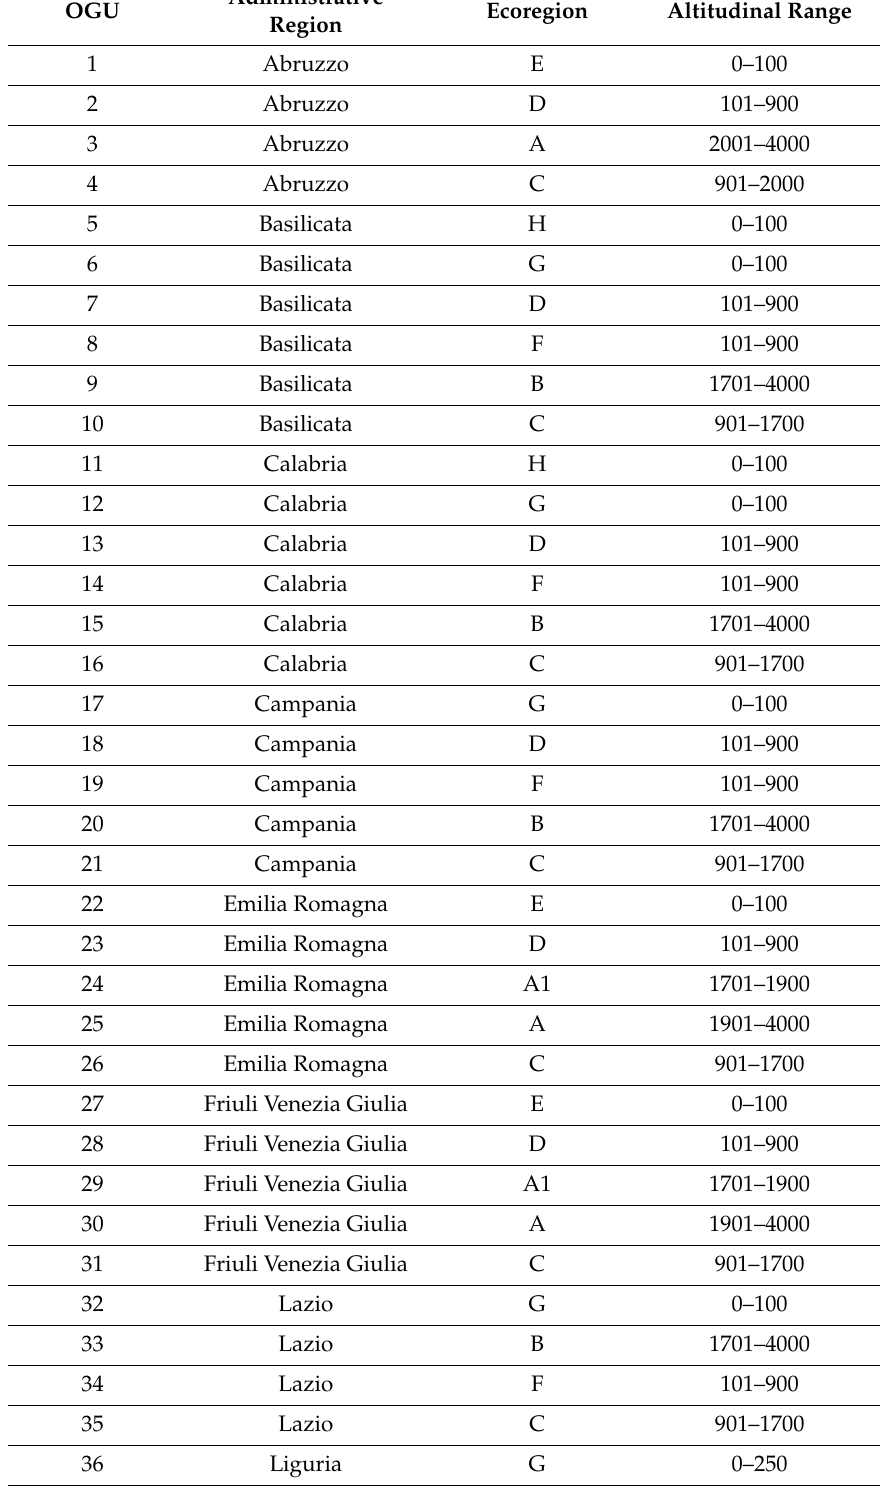
Table 1. Altitudinal range for each of the 97 OGUs. For each OGU, its name in the database, the ecoregion to which it belongs (see Figure 1, and the text for details), and the elevation range are